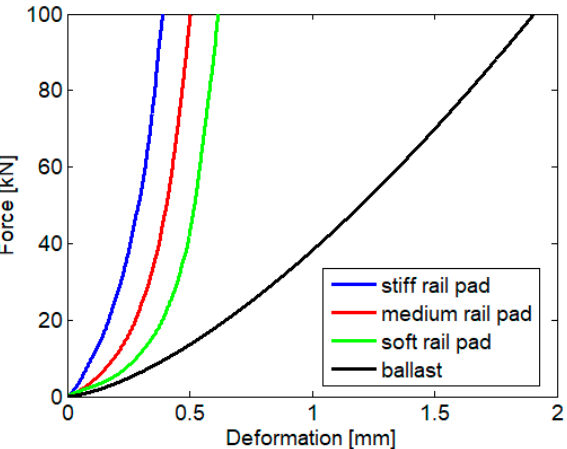
Figure 5. Nonlinear characteristic of the rail pad (based on [40]) and ballast (based on [5]). Each nonlinear characteristic is approximated by a bilinear function which has elastic and rigid parts (Figure 6) 0 ( )